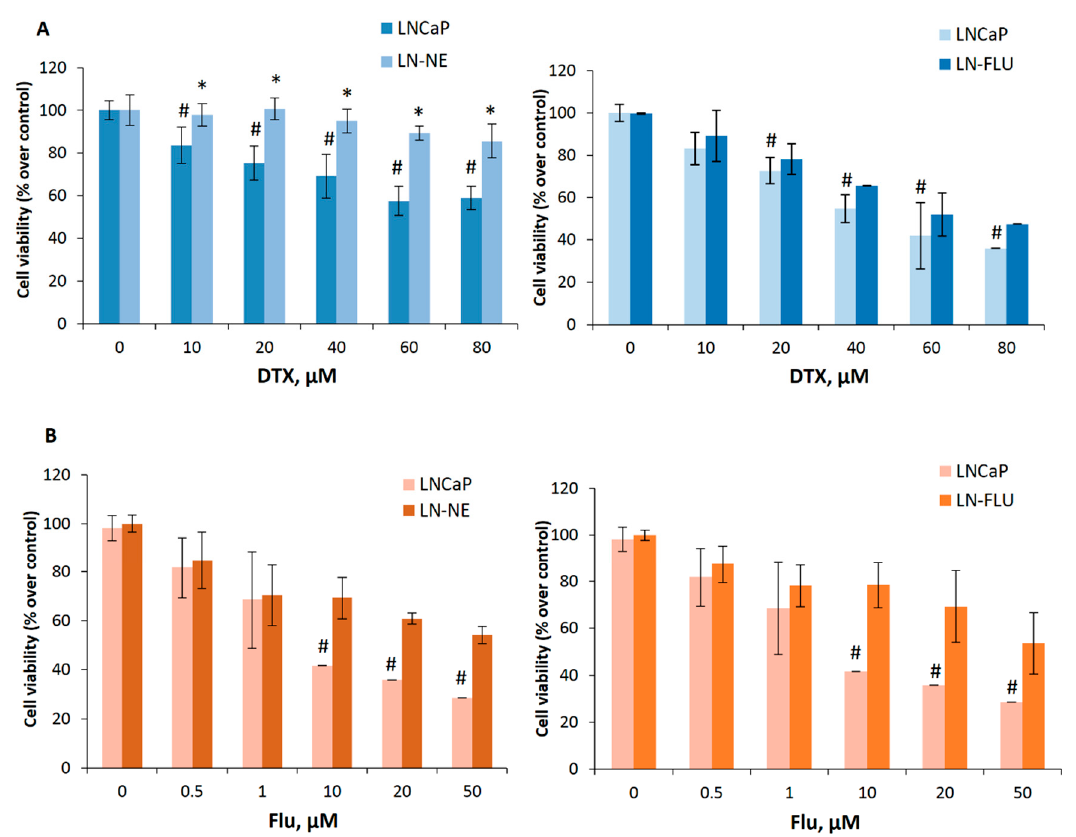
Figure 3. The cell lines LN-NE and LN-FLU are resistant to docetaxel and to 2-hydroxyflutamide. ( A ) LNCaP, LN-NE, and LN-FLU cells were incubated with increasing concentrations of docetaxel (DTX) for 24 h. Cell viabilities were determined by MTT assay and expressed as percentages of control (DMSO treatment). Experiments were run in quadruplicate and carried out at least two times on separate occasions. ( B ) LNCaP, LN-NE, and LN-FLU cells were incubated with increasing concentrations of 2-hydroxyflutamide (FLU) for 24 h. Cell viabilities were determined by MTT assay and expressed as percentages of control (DMSO treatment). Experiments were run in quadruplicate and carried out at least two times on separate occasions. * p < 0.01 significant difference between stem-like and parental cells and # p < 0.01 between treated and non-treated cells by two-way ANOVA and Tukey’s multiple comparisons test.